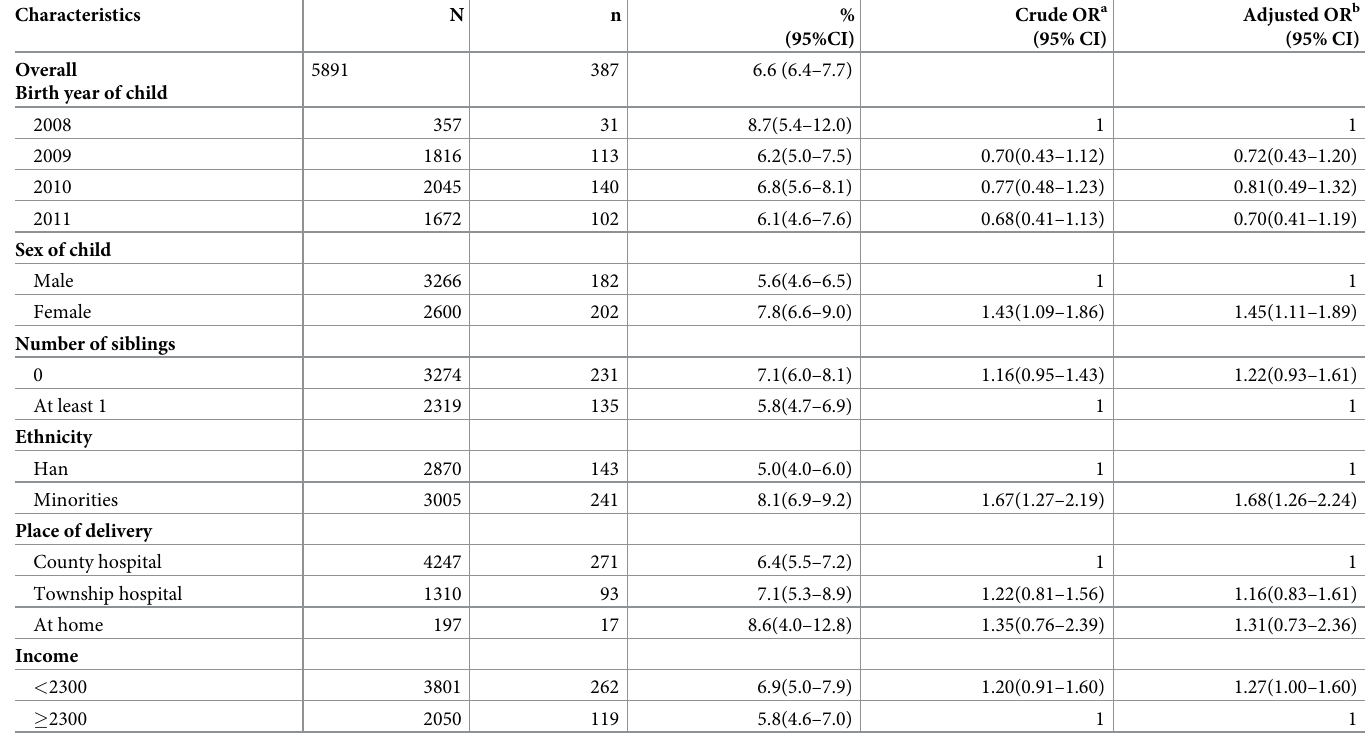
Table 2. Socio-demographic factors for low birth weight among children in 42 counties of Western China (N = 5891, 2011).